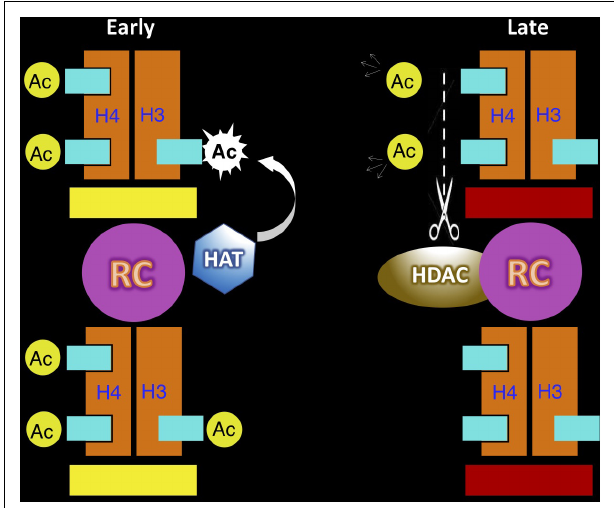
FIGURE 3 | Autonomous maintenance of asynchronous replication timing (ASRT). This model demonstrates how histone acetylation (Ac) at the replication origin may serve as a mark for the autonomous maintenance of replication timing on individual alleles. In cells set up to replicate one allele early (yellow bar) and the other late (red bar), the early allele is marked by acetylation of both histone H3 and H4 at the replication origin, while the late replicating allele lacks histone acetylation. During the next cycle the acetylated allele (left) will be recognized to undergo replication in early S, thus generating two copies of the DNA template, with the original nucleosome remaining on one copy (bottom) and a newly made nucleosome (top) placed on the other. Since histone H4 becomes acetylated immediately after its synthesis in the cytoplasm, this new nucleosome is already acetylated at these sites. Acetylation of histone H3 is carried out by a histone acetylase (HAT) that is associated with the replication machinery, but only in early S phase. Thus, following early replication the origin on both chromatids is now packaged with nucleosomes marked for early replication in the next cell cycle. The other allele in the same cell (right) is marked for late replication at the origin and is packaged with nucleosomes lacking histone acetylation. This allele is recognized for replication as the cell passes through early S phase, but will then undergoes replication during late S. The original nucleosome will remain with one of two DNA copies (bottom), while the other DNA template will get packaged with a new nucleosome, already acetylated on histone H4. During late S, the replication complex (RC) contains a cell-cycle-dependent histone deacetylase (HDAC) that can remove these H4 acetyl groups, thus guaranteeing that both chromatids will be packaged with un-acetylated histones and effectively regenerate the mark that directs late replication in the next cell cycle. It should be noted that this mechanism may also be able to accommodate the stem-cell switching mode of ASRT by automatically switching the acetylation state on each allele at the end of S phase in every cell cycle. As opposed to all other mechanisms for epigenetic maintenance which are carried out by “copying” specific marks, replication timing memory is time-based and takes advantage of differential cell-cycle